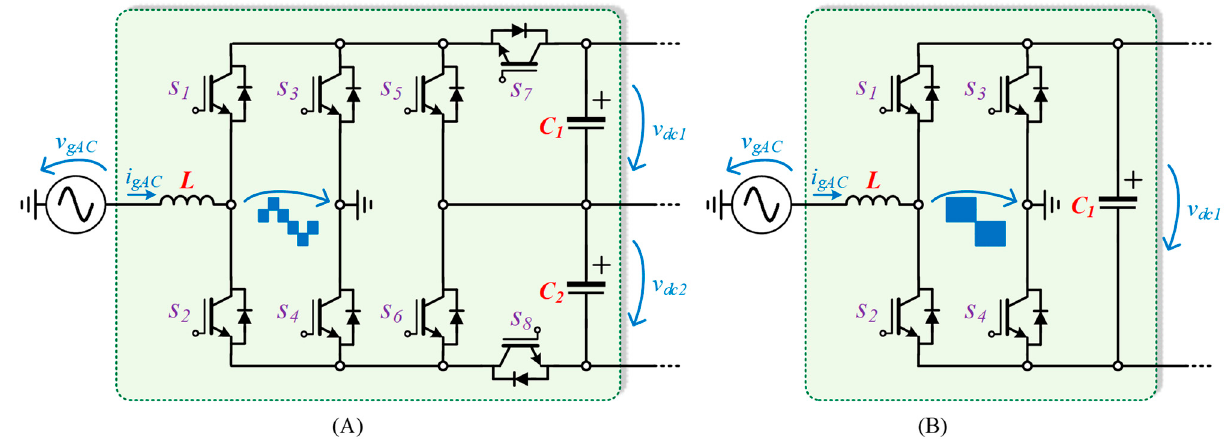
Figure 3. Converters under analysis: ( A ) Single-phase bidirectional multi-level topology with split DC-link for providing a bipolar DC grid; ( B ) Single-phase bidirectional topology for providing a unipolar DC grid.